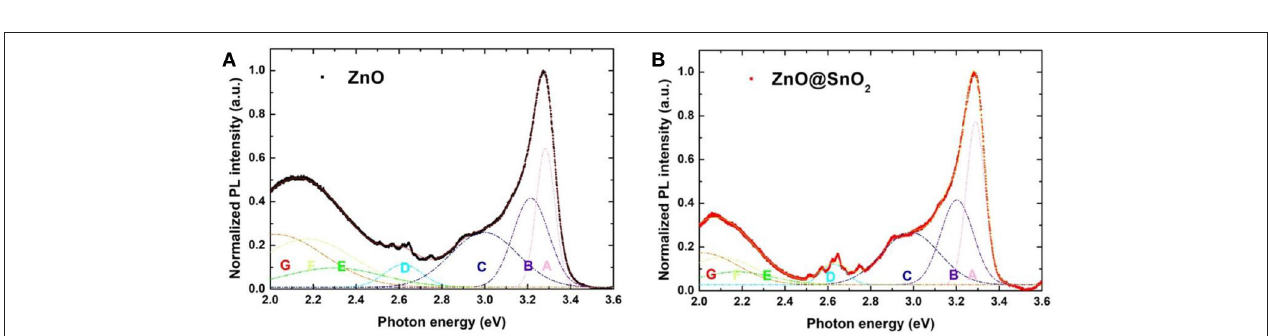
FIGURE 3 | PL spectra with several fitted emission peaks (from Peak A to Peak G): (A) ZnO NWs (B) ZnO@SnO 2 NWs.